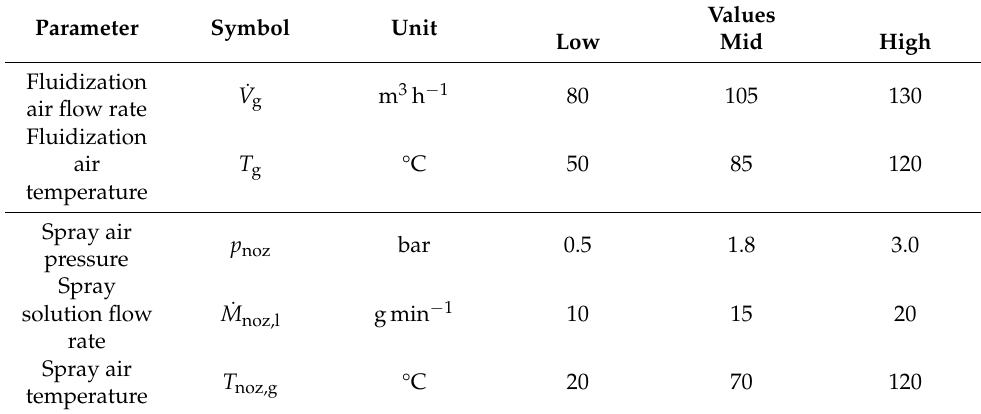
Table 1. Different values for parameters in the granulation experiments.